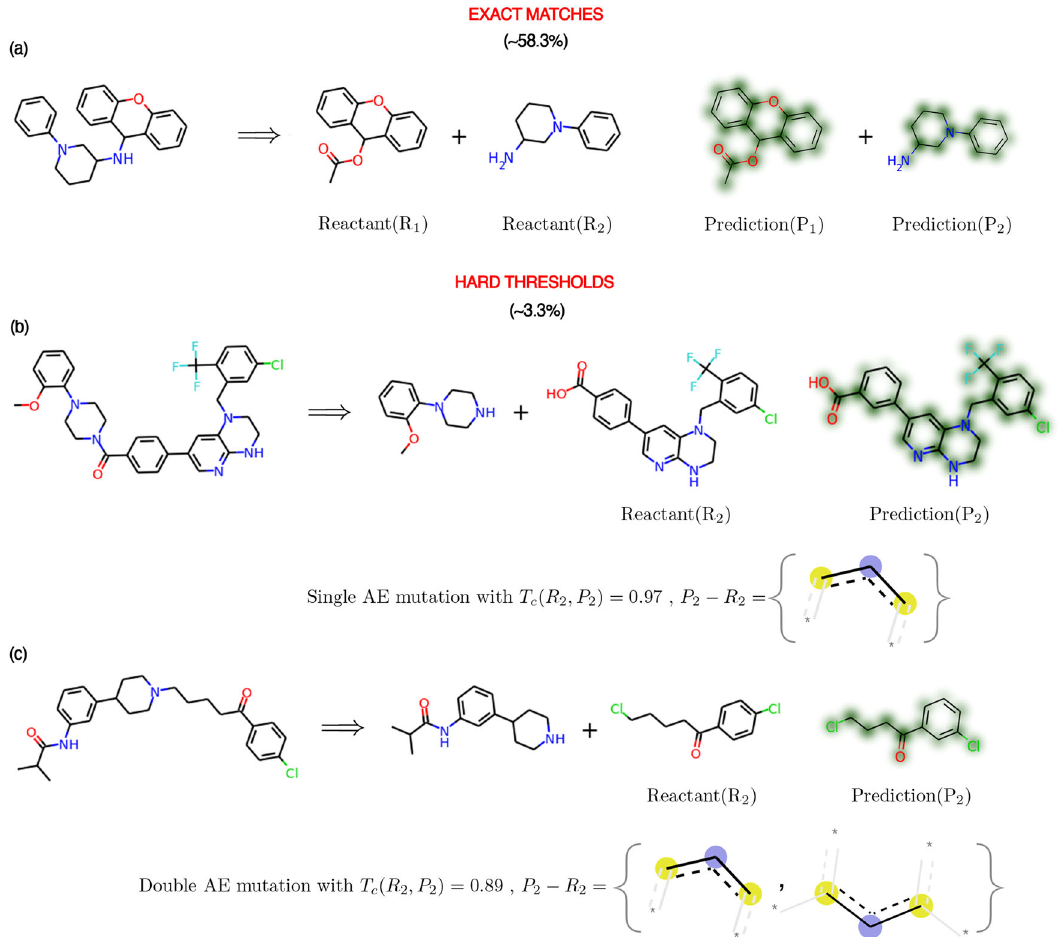
Fig. 4 Example of RetroTRAE predictions. Representative examples of a exact predictions, b predictions with a single and c double fragment mutations are shown. RetroTRAE predicted 58.3% of test set exactly. Considering highly similar predictions with single and double mutations increased the success rate by 3.3%. Distinct fragments are given as SMARTS patterns. Predictions are drawn as similarity maps using the Morgan fi ngerprints. For hard thresholds, the fi rst reactant is predicted correctly and the qualities of the second reactants are evaluated. The fragments only belonging to the prediction or its true counterpart are given as set notation differences, which allows us to describe the chemical change more concretely. Colors indicate atom-level contributions to the overall similarity (green: increases in similarity score, red: decreases in similarity score, uncolored: has no